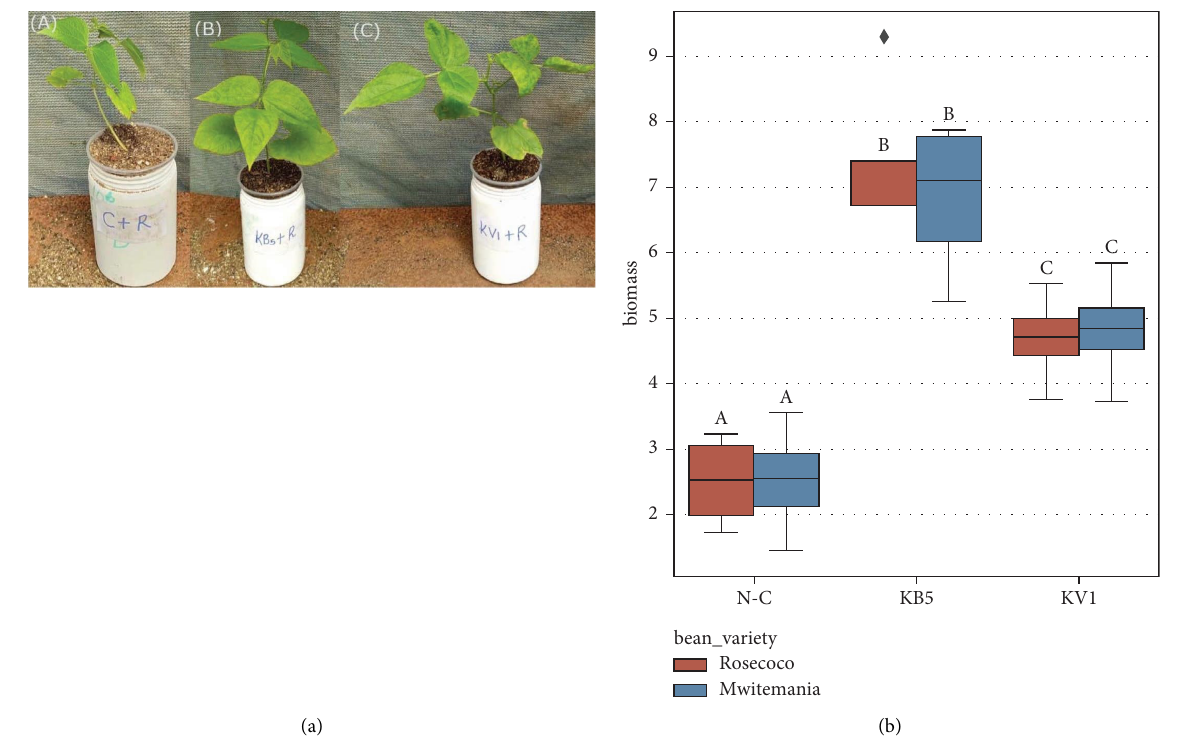
Figure 5: (a) Box plot showing the efects of bacteria strains inoculation on phenotypic characteristics of a Rose coco variety under phosphorus-free nutrient in a screen house: (A) noninoculated control, (B) inoculated with KB5 strain,and (C) inoculated with KV1 strain, and (b) Efects of bacteria strains on total dry weights in grams for both varieties: (A) biomass of negative control, (B) biomass of plants inoculated with KB5, and (C) biomass of plants inoculated with